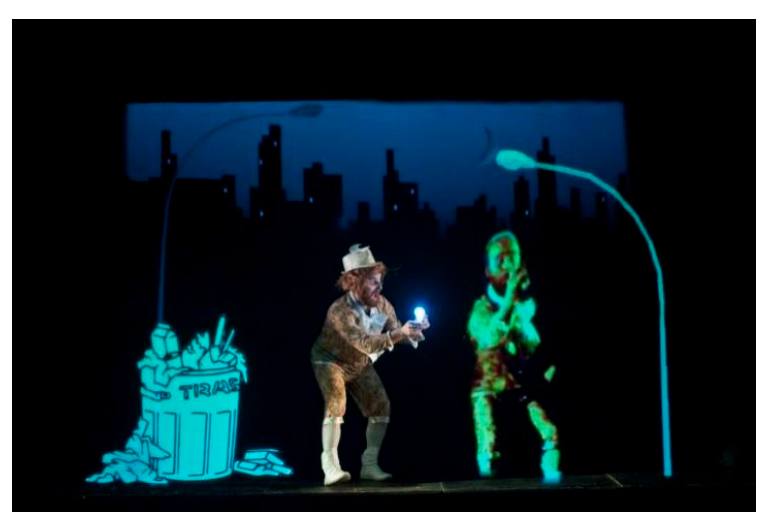
Figure 3. “Augmented Pinocchio” a performance directed by Michele Cremaschi, 2014, real actors interact with holograms on the stage.